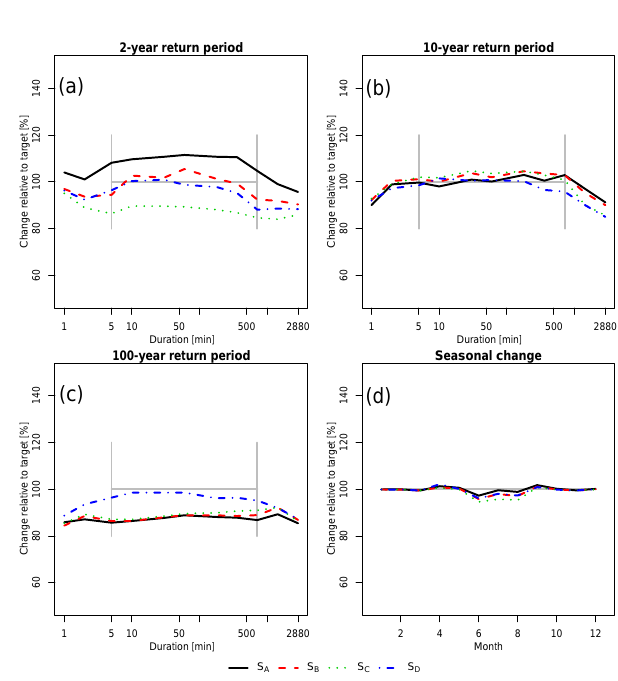
Figure 4. Performance of the different selection criteria, S A − S D , in producing (a) 2-year extremes, (b) 10-year extremes, (c) 100-year extremes and (d) seasonal changes according to the perturbation schemes listed in Tables 3 and 4.